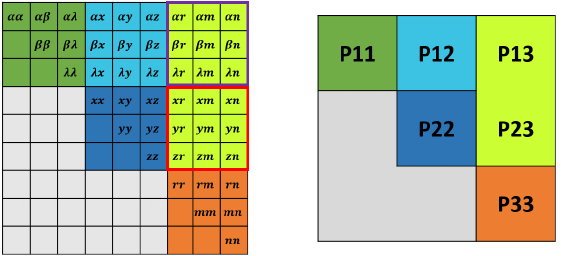
Figure 4. Illustration of an example of covariance computation using the block-streaming method with 3 blocks ( B = 9, B max = 3).